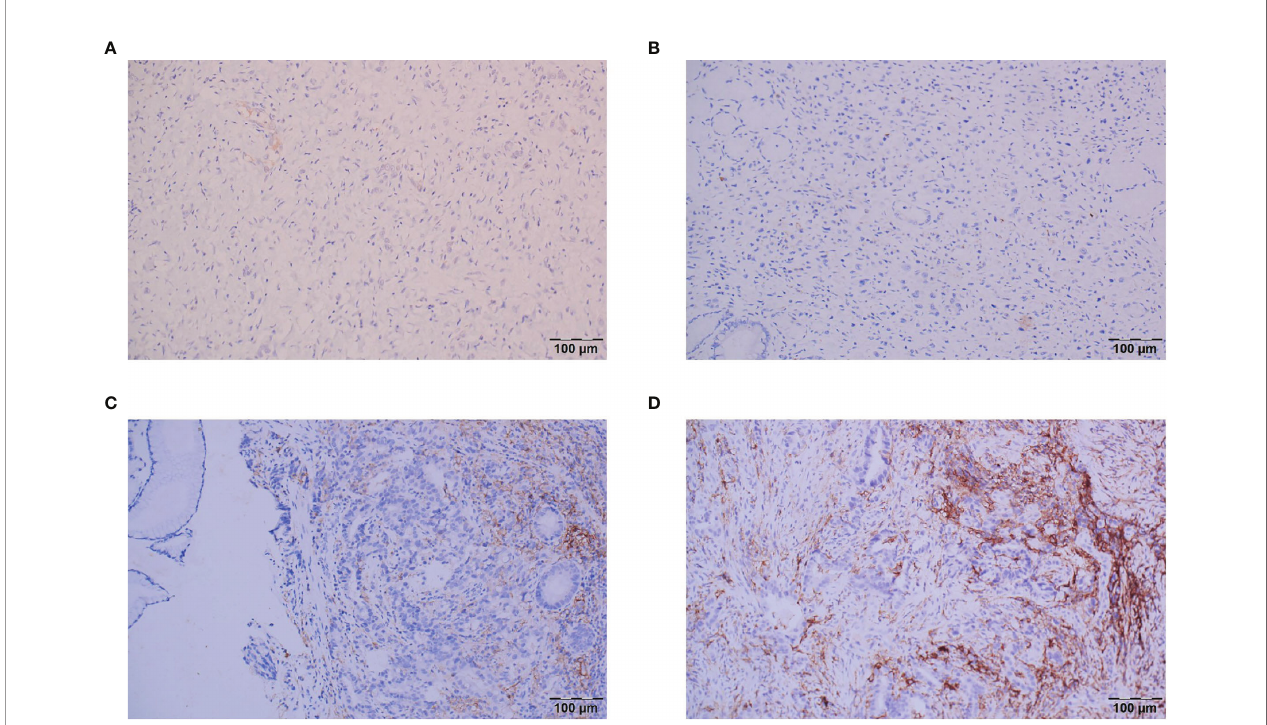
FIGURE 2 | Representative images of the different CPS categories. (A) CPS<1; (B) CPS=1; (C) CPS=5; (D) CPS ≥